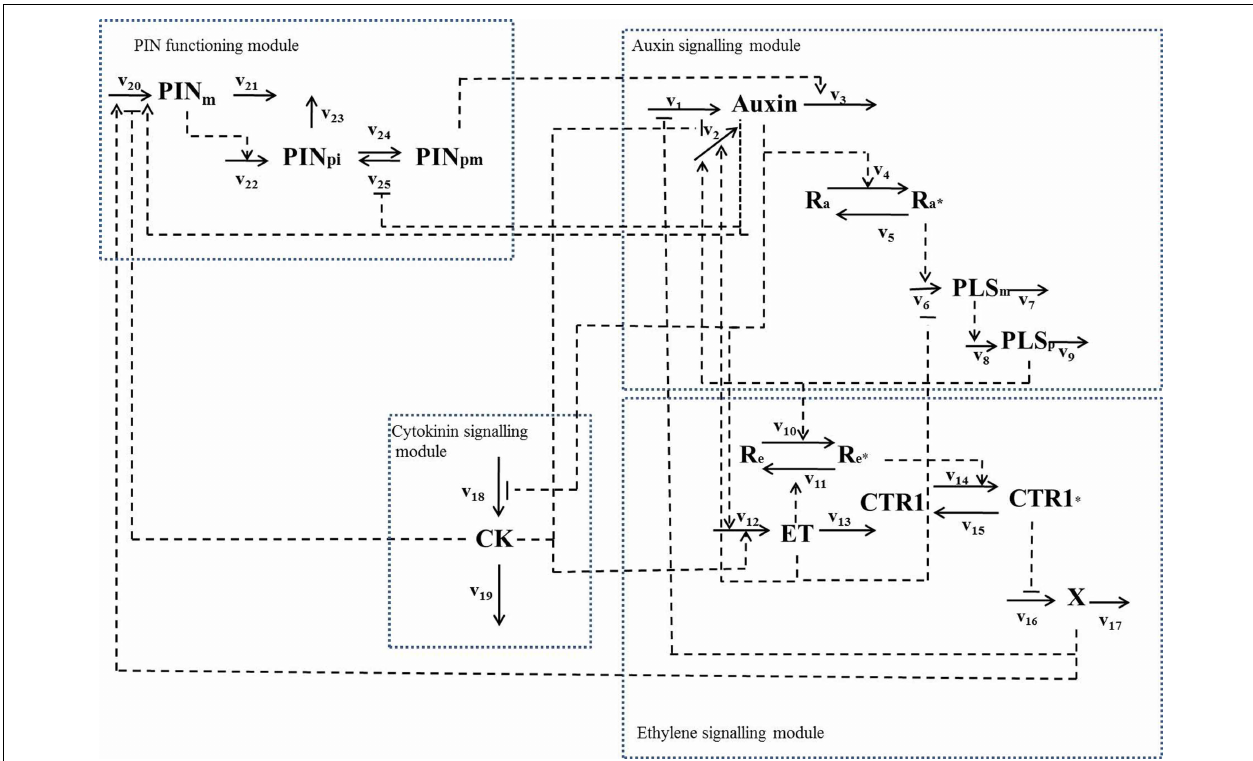
FIGURE 2 | Ahormonalcrosstalknetworkofauxin,ethyleneandcytokinin for root development, showing that change in one signaling component leads to change in other signaling components in the network (modified with permission from Liu et al., 2013). The reaction rates are: v1, total auxin influxfromallneighboring; v2,auxinbiosynthesisrateinthecell;v3,totalauxin efflux from the cell; v4, rate for conversion of the inactive form of the auxin receptor,Ra,toitsactiveform,Ra ∗ ;v5,rateforconversionoftheactiveformof the auxin receptor, Ra ∗ , to its inactive form, Ra; v6, transcription rate of the POLARIS (PLS)gene; v7, decay rate of PLS mRNA; v8, translation rate of the PLS protein; v9, decay rate of PLS protein; v10, rate for conversion of the inactive form of the ethylene receptor, Re, to its active form by PLS protein (PLSp), Re ∗ ; v11, rate for conversion of the active form of ethylene receptor, Re ∗ , to its inactive form, Re; v12, ethylene biosynthesis rate; v13, rate for